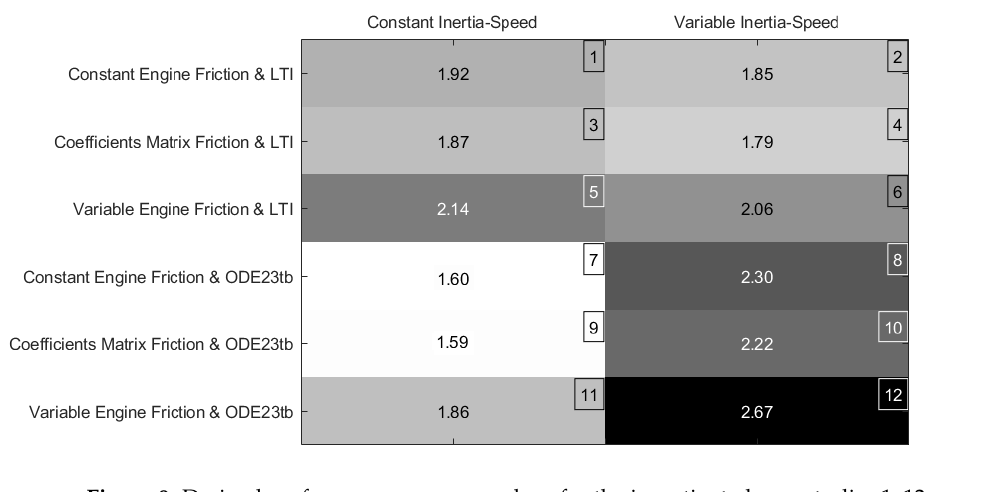
Figure 9. Derived performance measure values for the investigated case studies